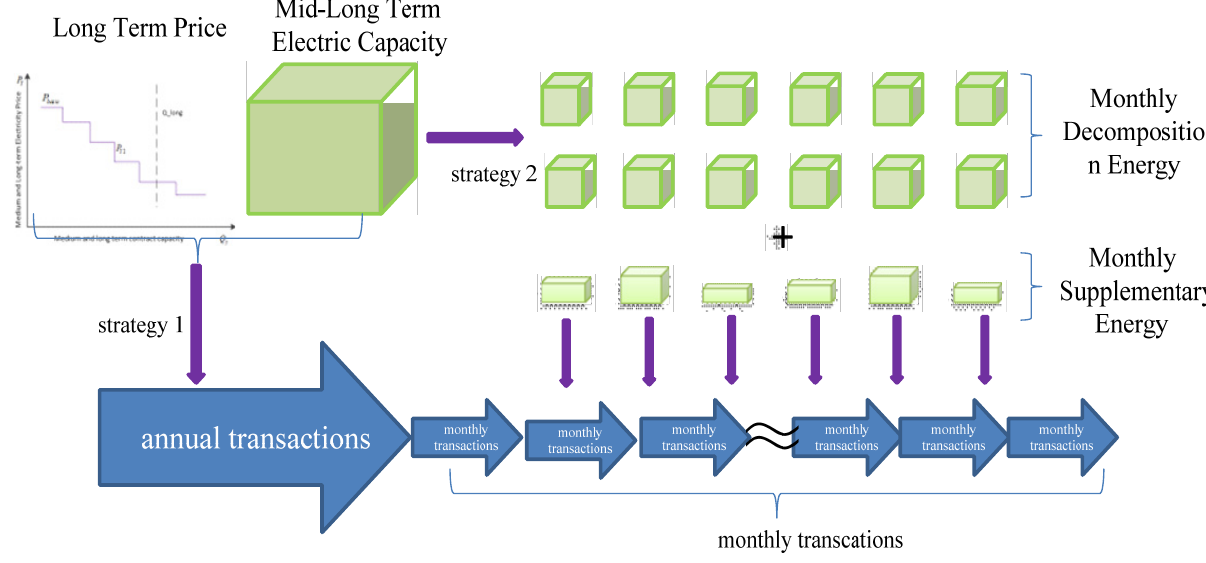
Figure 4. Medium- and long-term trading rules of the past electricity market .